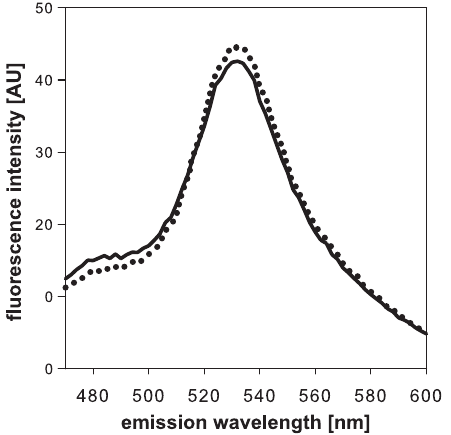
Figure 1. Fluorescence emission spectrum of CitA with and without 500 m M citrate. The FRET sensor CFP-CitA-Venus was purified and the fluorescence emission recorded at an excitation of 433 nm in a fluorescence plate reader. The dotted line represents the spectrum of the protein in buffer, the dashed line the protein after addition of 500 m M